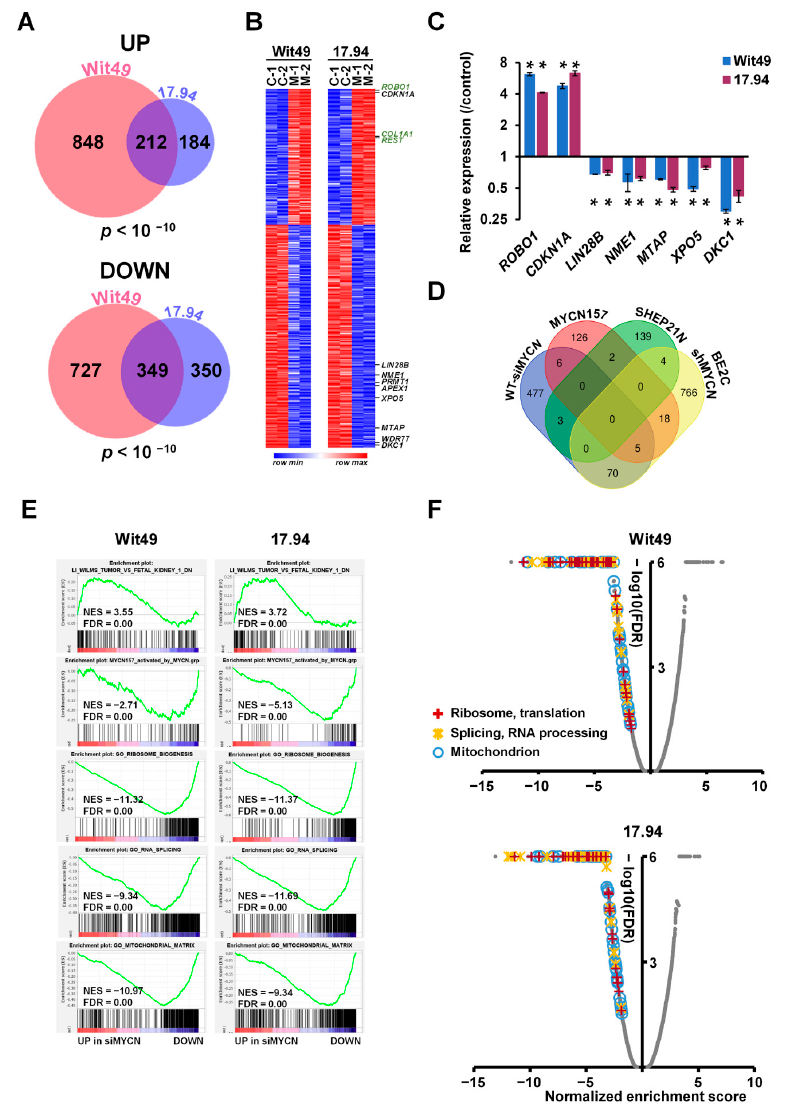
Figure 3. Genes and pathways identified by RNA-seq in MYCN-depleted anaplastic WT cells. ( A ) Venn diagrams showing highly significant overlaps between differentially expressed genes (DEGs) in Wit49 and 17.94 after MYCN depletion for 48 h, for up- and downregulated genes. DEGs were determined as statistically significant ( p < 0.05) and having a minimum shrunk fold change (a conservative corrected value) of 1.2, calculated by using DESEQ2. The probability values for shared genes are indicated. ( B ) Heatmap of shared 561 DEGs in Wit49 and 17.94. Expression data of replicate control samples are indicated as C-1 and C-2, while those of MYCN depleted samples are shown as M-1 and M-2. Examples of known MYCN target genes are shown in black, while genes associated with kidney development or Wilms’ tumour predisposition are highlighted in green. ( C ) Validation of identified select MYCN-regulated genes in WT cells by qPCR, 48 h after MYCN knockdown. A representative of three biological replicates is shown. Significance was calculated based on the biological replicates (* p < 0.05, t -tests). ( D ) Venn diagram showing overlaps of MYCN-regulated genes in WT described in this study, with MYCN target genes identified in neuroblastomas. ( E ) GSEA plots showing upregulation of gene signatures repressed in WT as compared to fetal kidney, upon depletion of MYCN. MYCN-activated genes of the MYCN157 signature, identified in NB, were downregulated. Examples of gene set enrichment analysis (GSEA) of downregulated Gene Ontology (GO) gene sets associated with ribosomal and mitochondrial function and splicing in MYCN-depleted WT cells are also shown. ( F ) Volcano plots of gene set enrichment analysis on MYCN depletion transcriptomes in WT cells. Normalised enrichment scores and false discovery rates (FDR) were calculated. Gene Ontology gene categories indicated universal downregulation of gene sets linked to ribosomal and mitochondrial function, as well as those associated with RNA processing and splicing. Scores of all gene sets are shown in grey, while those of statistically significant gene sets (FDR < 0.05) in the highlighted functional categories are indicated according to the